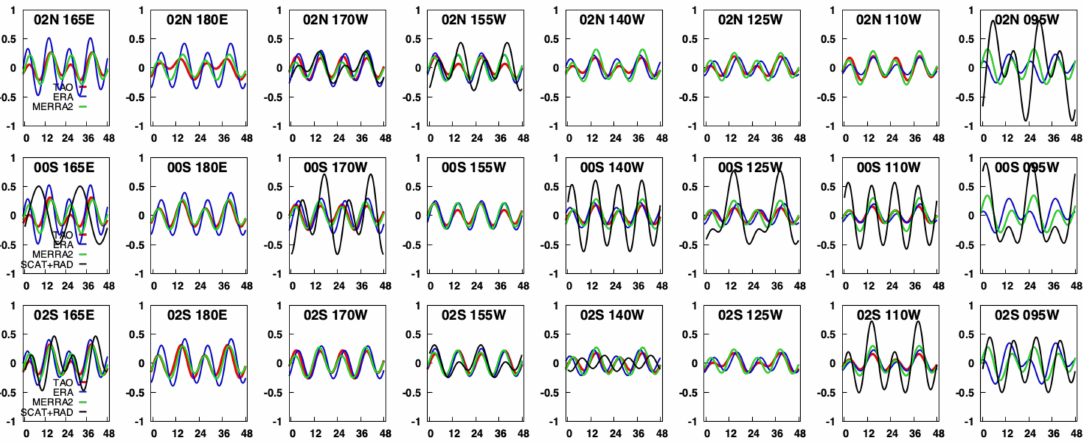
Figure 11. Same as Figure 8, but showing zonal ( u ) wind components from 2015, a year with strong El Niño conditions. Positive (negative) values indicate westerly (easterly) winds relative to the daily mean. For many locations, the TAO-TRITON and SCAT + RAD data are not shown owing to the limited number of